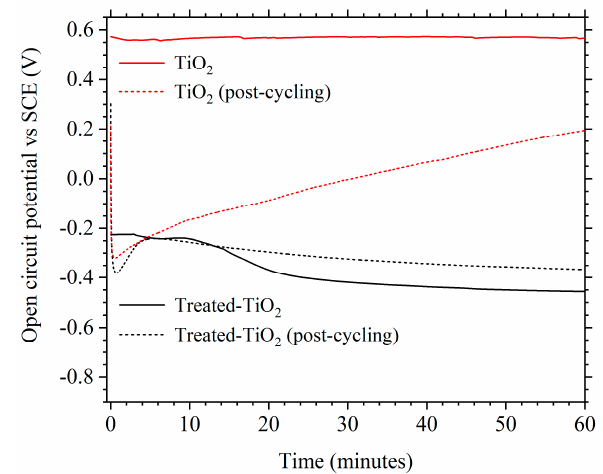
Figure 9. The 1 h OCP measurements of TiO 2 (red) and treated-TiO 2 (black) taken before cycling (dashed-line) and after the cycling regime presented in Figures 5 and 6 (solid-line).